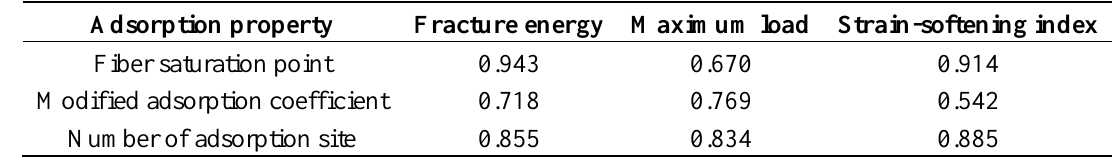
Table 2. Coefficients of determination* calculated for linear relationships between adsorption properties and fracture properties in the TL